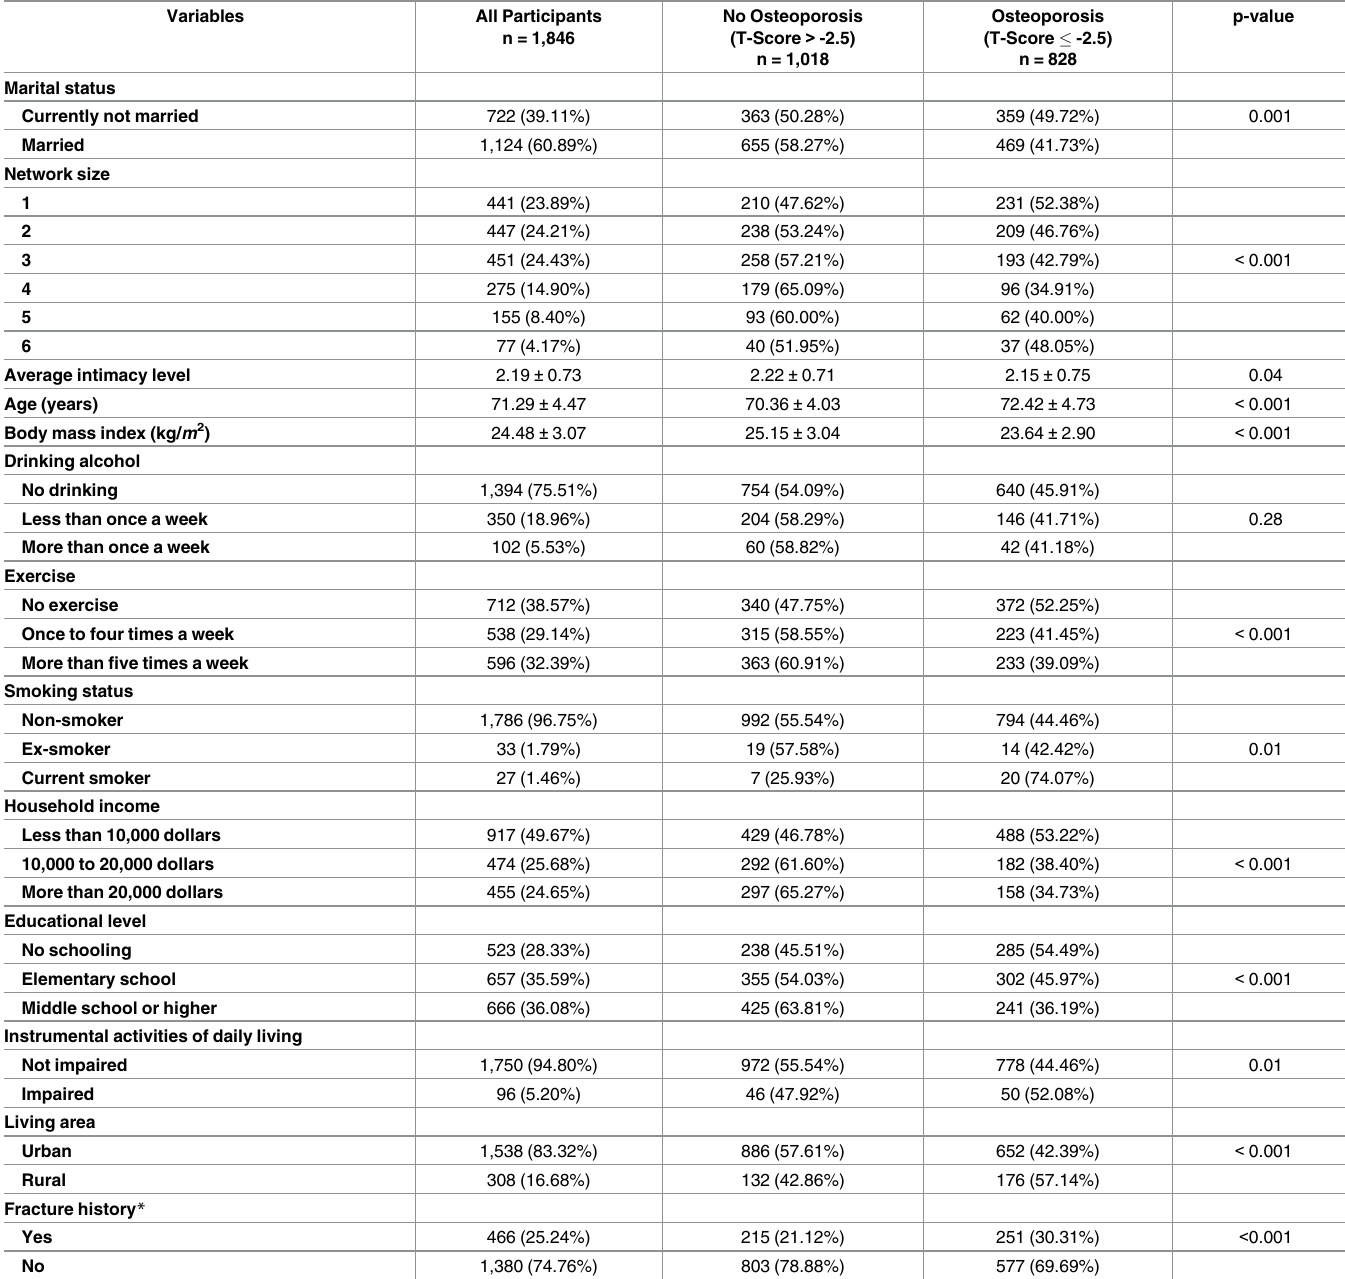
Table 1. General characteristics of study